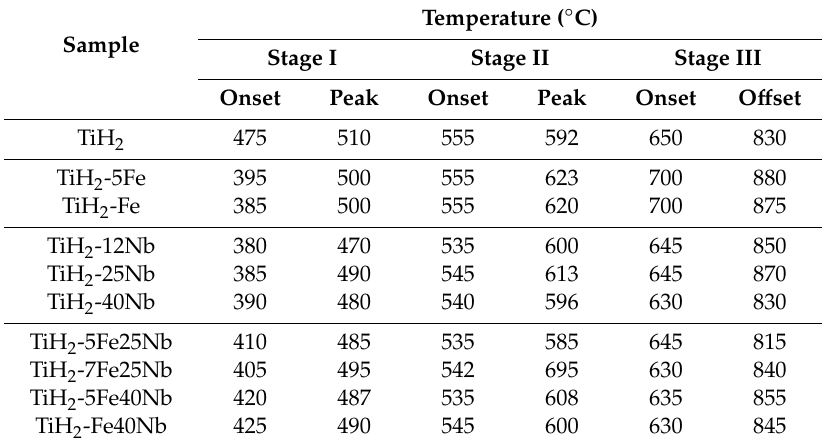
Table 2. Transformation temperatures found during the dehydrogenation process analyzed by di ff erential thermal analysis